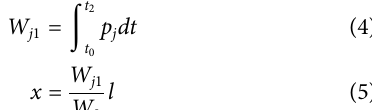
FIGURE 6 | Single-pole abnormal grounding instantaneous power.